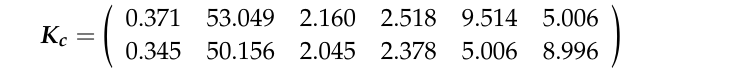
Table 6. Details of weighing matrices used for robustness analysis.